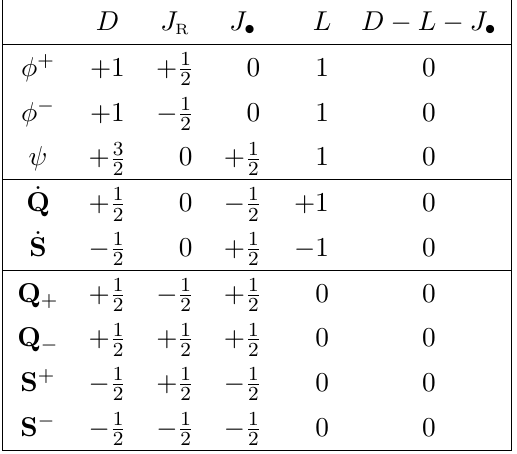
Table 6. The u(1) charges of the fields and generators in the su(1 | 1)